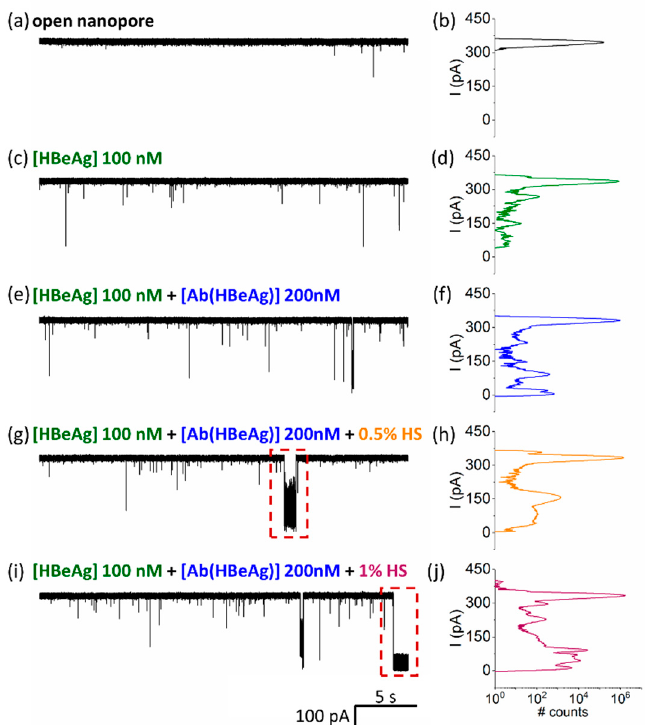
Figure 6. HbeAg–Ab(HBeAg) complex detections with a single α -HL nanopore in the presence of human serum proteins. Representative, original traces and related all-points histograms of the ionic current measured at Δ V = +180 mV across an open nanopore ( a , b ), then in the presence of cis -added Ag(HBe) antigen (100 nM) ( c , d ), followed by addition of the Ab(HBe) antibody (200 nM) ( e , f ), and subsequent pipetting of human serum (HS) at a 0.5 % ( v / v ) ( g , h ) and, respectively, 1% ( v / v ) concentration ( i , j ). In certain cases, the HS addition led to the non-specific occlusion of the nanopore (red rectangle in panels ( g , i ), followed in certain cases by lipid membrane rupture.